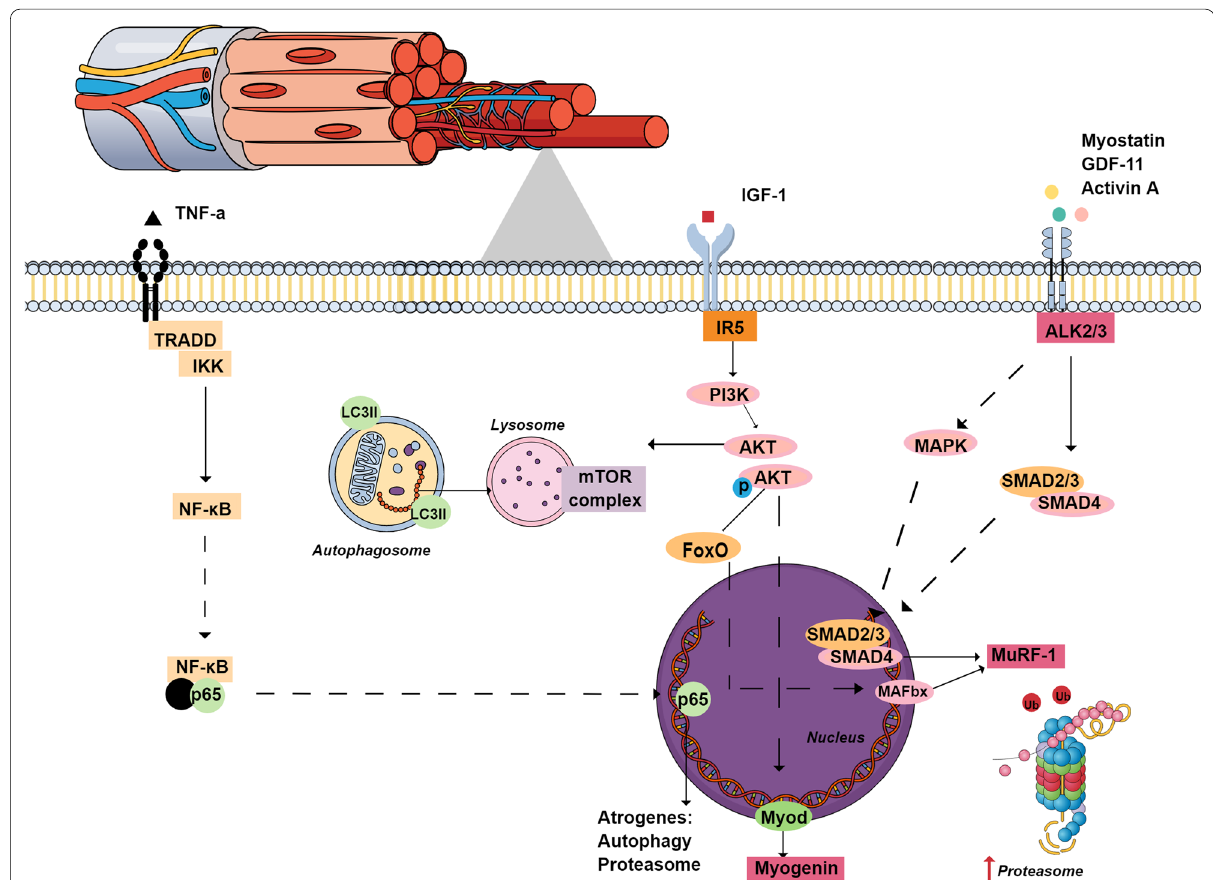
insulin to their receptors. IGF-1 activates IRS–PI3K–Akt–mTORC1 signaling. mTOR complex blocks proteolysis by inhibiting autophagy initiation factors Unc-51 like autophagy activating kinase (ULK) 1/2. In atrophy response there is also an inhibition of Akt protein by blocking its phosphorylation which results in inhibition of Myod and Myogenin-important myogenic regulatory proteins that are expressed during myogenesis. Thus, inhibition of Akt can activate the forkhead box O family of transcription factors (FoxO) members that translocate to the nucleus and promote gene transcription of MAFbx and MurF-1, responsible for proteasome activity and ubiquitination. TNF alpha signaling perturbations may also cause atrophy by downregulate NF-kB-a transcription factor NF-kB activation whose is required for maximal atrophy; NF-kB activation induces transcriptional upregulation of the E3 ubiquitin-ligase MuRF1 and MAFbx. Myostatin and its signaling pathway are involved in myogenesis and atrophy. The myostatin dimer first binds to ActRIIB, then to ALK4/5 to form a complex with Smad2/3/4. Different transcription factors bind to the Smad2/3/4 complex, resulting in various functions of the Smad signaling pathway. These pathways mediate the transcription of myogenic regulatory factors (myogenin, Myf5, MyoD), MuRF-1, and atrogin-1 to regulate myogenic differentiation and muscle mass. Abbreviations: TNF-a: Tumor necrosis factor alpha; IGF-1: insulin-like growth factor 1; GDF-11: Growth differentiation factor 11; ALK2/3: Activin receptor-like kinase 2 and 3; MAPK: Mitogen Activated Protein Kinase; PI3K: phosphatidylinositol 3-kinase; AKT: Protein kinase B; FoxO: forkhead box transcription factor; p65: protein 65; MAFbx: muscle atrophy F-box; MuRF-1: Muscle RING Finger-1; mTOR: mammalian target of rapamycin; NF-kB: nuclear factor kappa B;